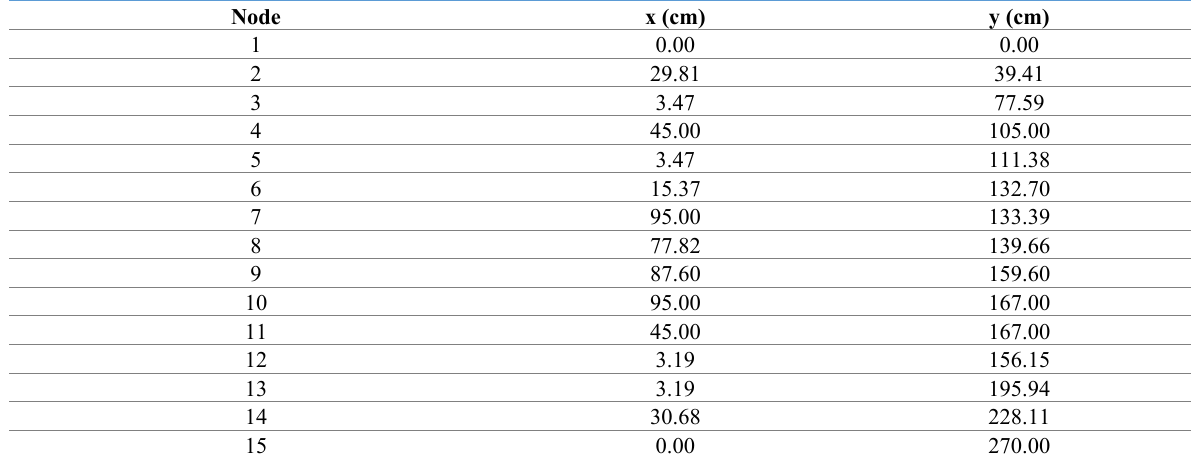
Table 3. Coordinates of truss model for f = 40% Node x (cm)